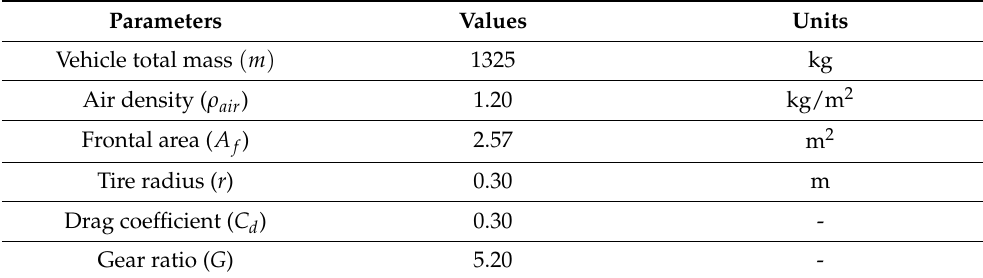
Table 1. Electric vehicle parameters.